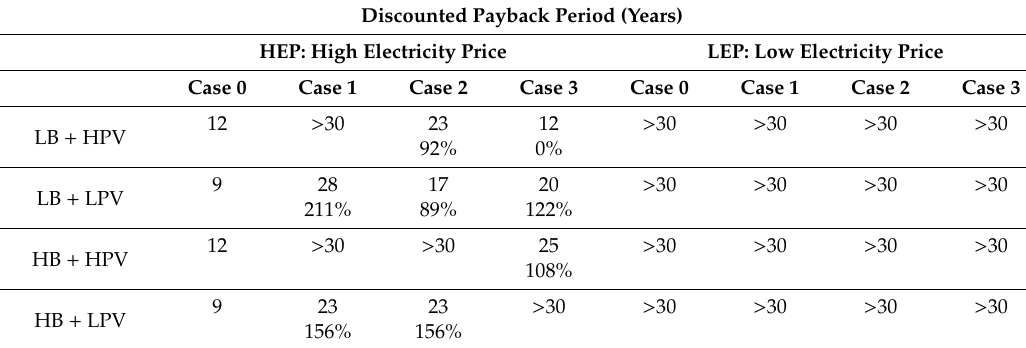
Table 9. DPBP according to electricity prices and